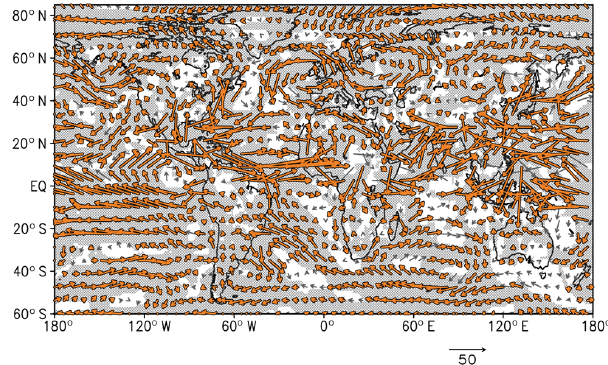
Figure 8. Trend shift vector map of moisture flux using JRA-55 (kgm − 1 s − 1 10 years − 1 ) (1958–2014: JAS). The orange bold vec- tor and hatching represent areas where northward or eastward mois- ture flux trends changed sign between the two parts of the study period (tan θ 1 · tan θ 2